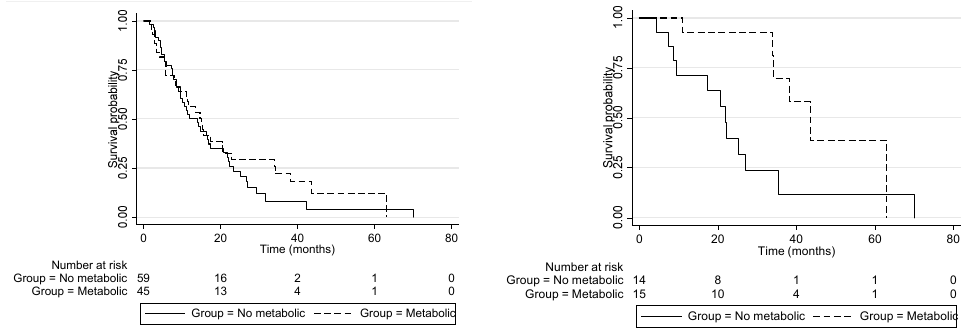
Figure 2. Overall survival. ( Left ) Patients treated with chemotherapy: the median OS was 11.5 months (95% CI 8.4–14.8), and there was no difference between metabolic and non-metabolic groups (11.5 months [95% CI 5.8–15.3] vs. 11.5 months [95% CI 6.7–16.2]; p = 0.406). ( Right ) Patients treated with surgery: the median of the metabolic group was significantly better than that of the non-metabolic group (43.4 [95% CI 33.9-NR] vs. 21.8 months [95% CI 8.6–26.9]; HR = 0.23, 95% CI 0.06–0.86; p =